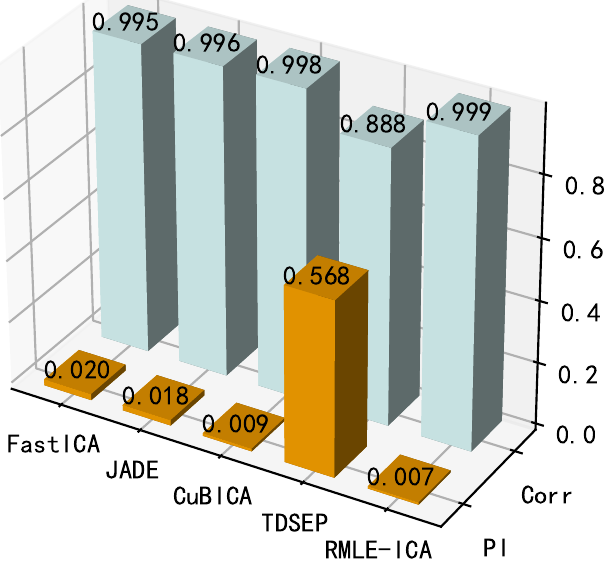
Figure 16. Comparison of steady-state performance between proposed algorithm and conventional al-